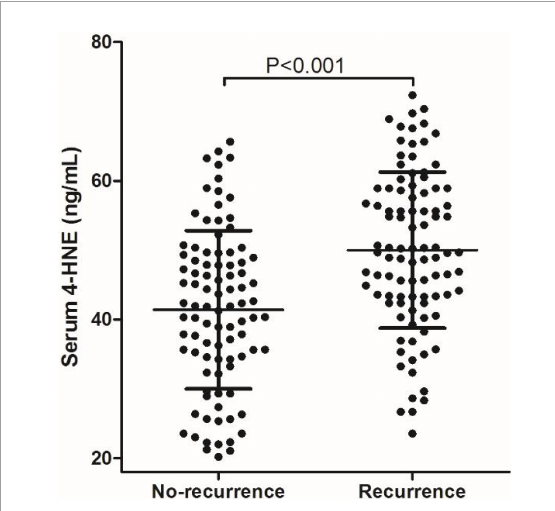
FIGURE2 Scatter plot suggests a positive correlation between serum 4-hydroxynonenal (4-HNE) and triglyceride in primary cerebral infarction patients.